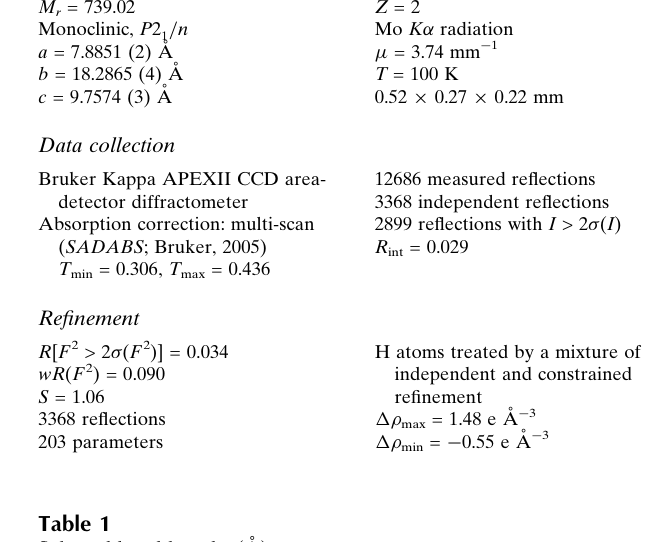
Selected bond lengths (A˚ ).